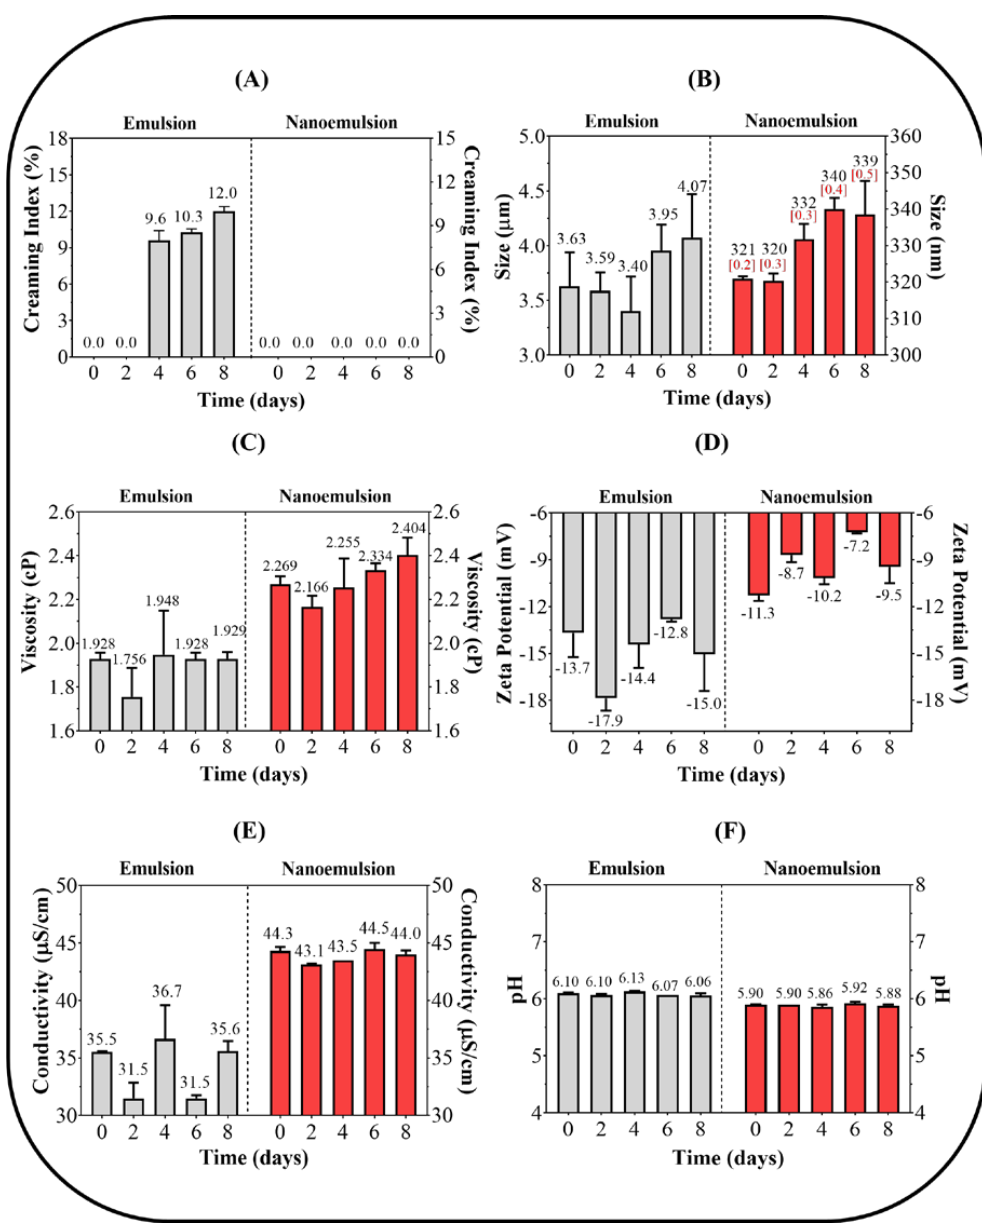
Figure 3. Results of (A) creaming index, (B) drop size, (C) viscosity, (D) zeta potential, (E) electrical conductivity, and (F) pH for coarse emulsion and nanoemulsion systems. In Figure 3B, the PDI values are presented in red brackets for the nanoemulsions only.